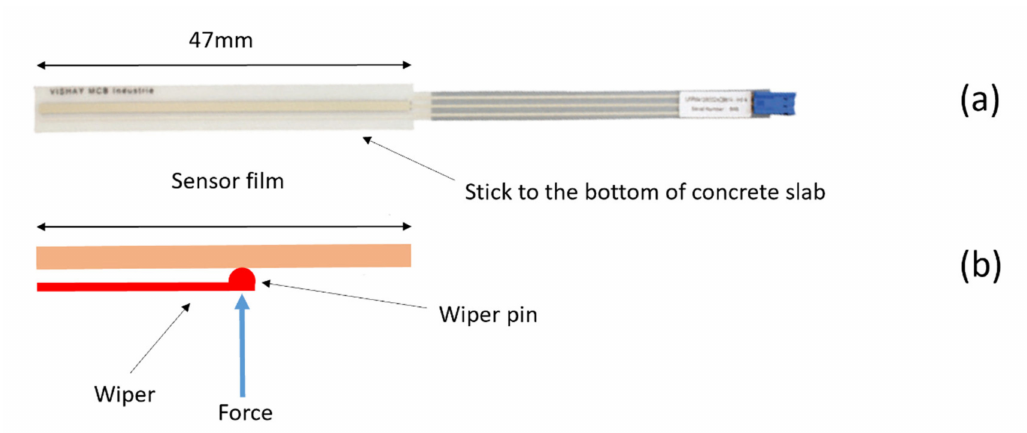
Figure 1. ( a ) Sensor film and ( b ) the sensory